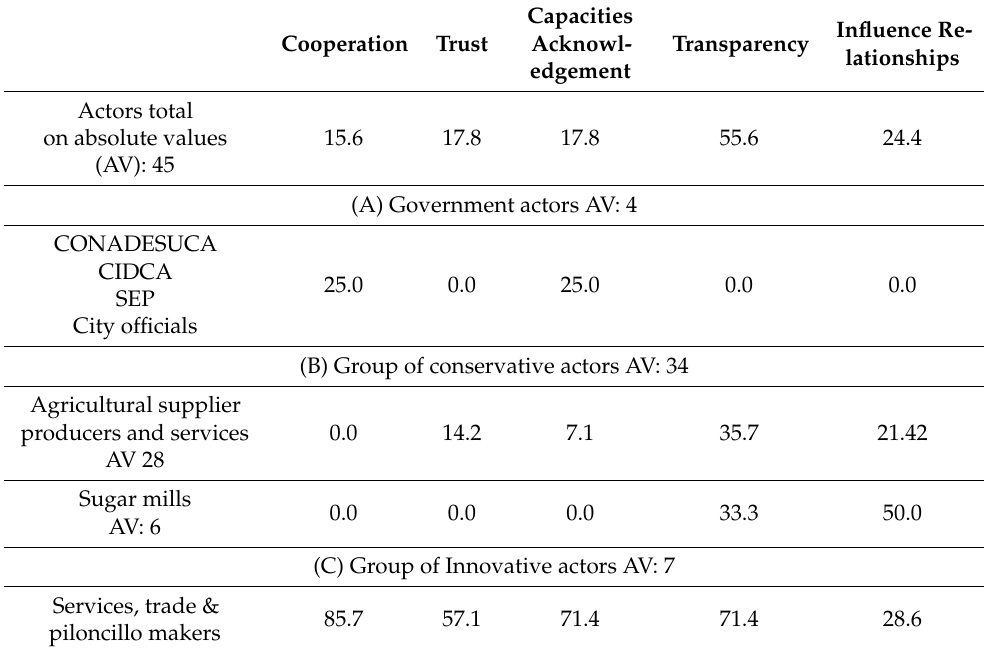
Table 2. Different democratic and SSE values appreciation.